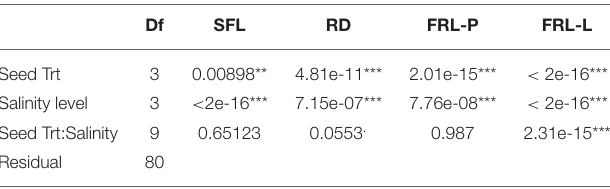
TABLE 4 | ANOVA table of Phaseolus vulgaris morphological parameters measured from pot